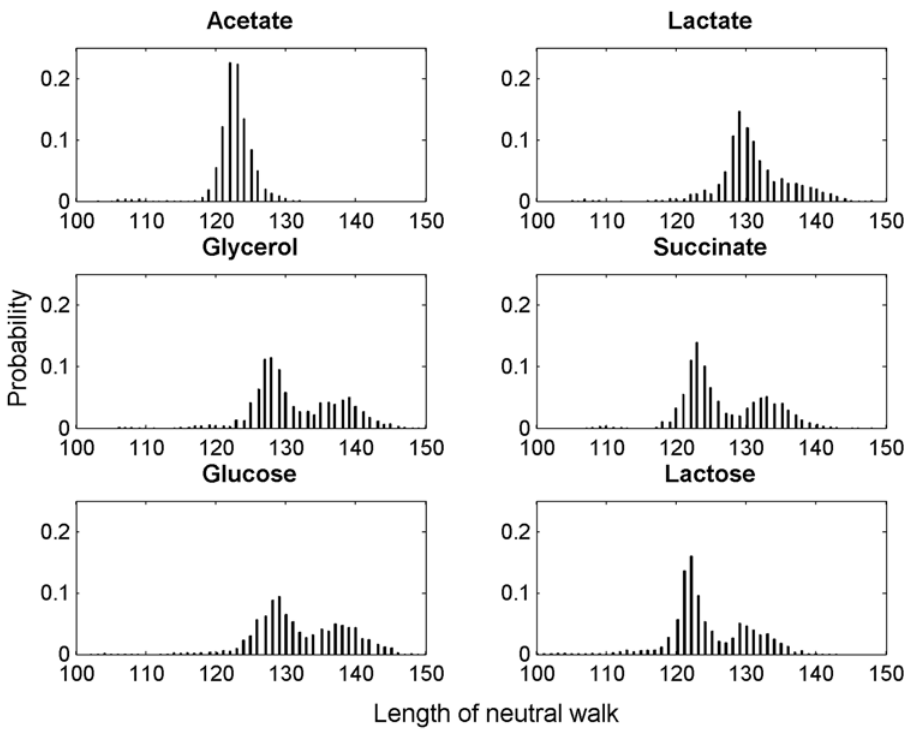
Figure 4. Distribution of the lengths of neutral walks in different environments. Neutral walks were performed as described in Materials and Methods. The length of a neutral walk corresponds to the Hamming distance between the final and starting genotypes associated with the walk.